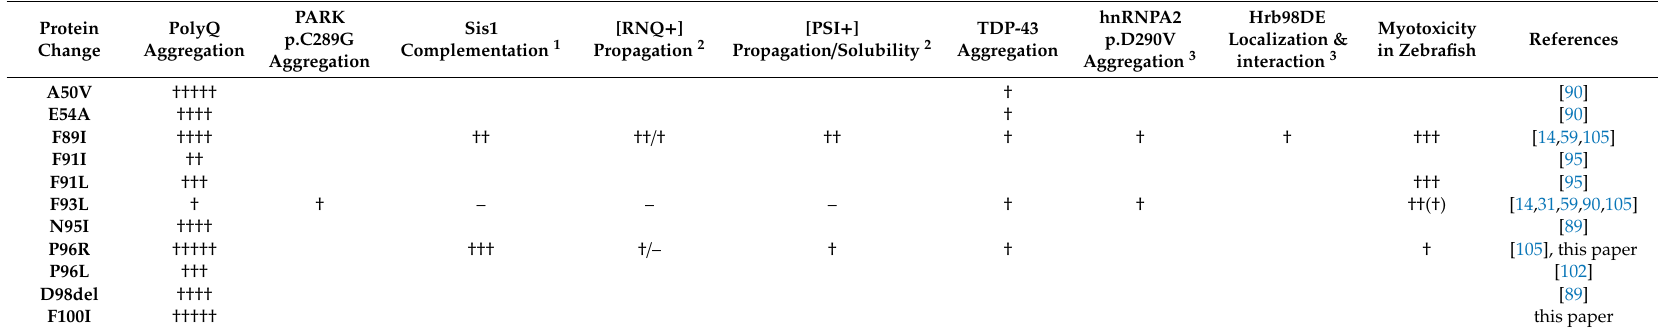
Table 3. Functional consequences of DNAJB6